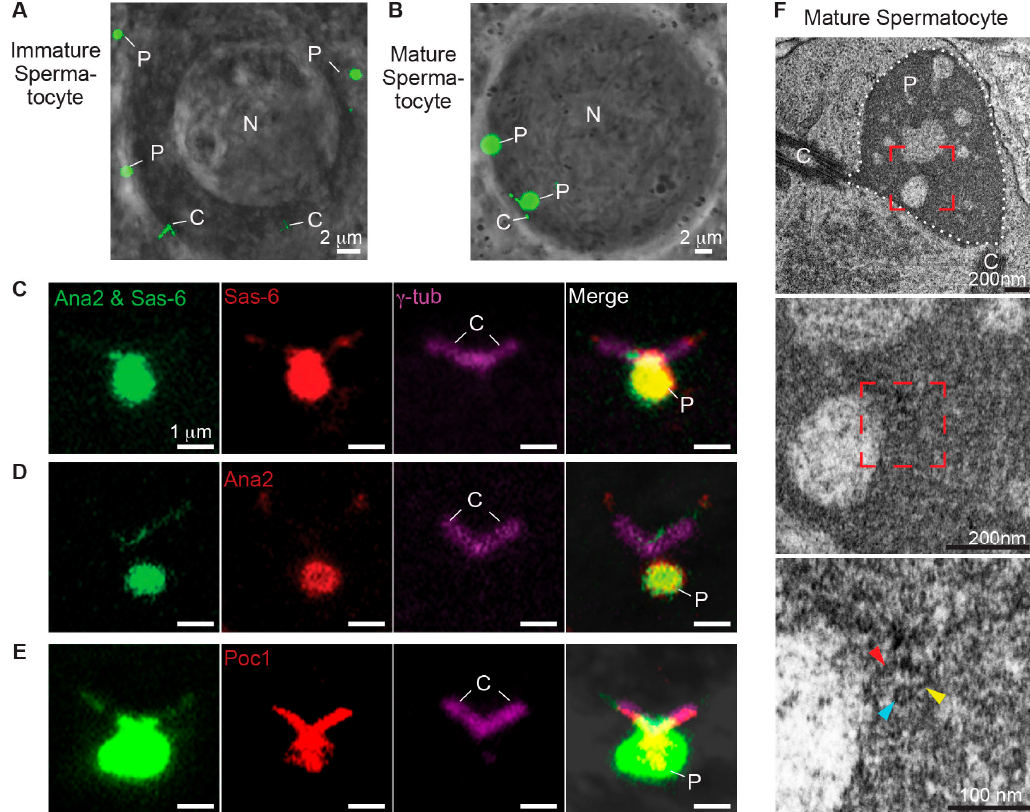
Figure 4. Ectopic particles contain Poc1B . ( A , B ) Co-overexpression of Ana2GFP and Sas-6GFP induced the formation of ectopic particles. Immature spermatocyte contained two centrioles (C) and ectopic particles (P) in the cytoplasm (A). Mature spermatocyte contained ectopic particles connected to the two centrioles and in the cytoplasm (B). Images were obtained by live cell imaging. ( C–E ) Ectopic particles were attached to the γ -tubulin labeled centrioles. Sas-6 antibodies labeled the particle and the centrioles’ tip ( C ), Ana2 antibodies labeled the particle and centrioles’ tip ( D ), and Poc1 antibodies labeled the particle and the centrioles ( E ). ( F ) Ectopic particles were composed of PCL-like structures in mature spermatocytes. Low electron microscopy magnification (upper row) showed dense PCL-like structures attached to the two centrioles (red dotted box). The electron dense area is outlined with white dotted lines. Intermediate magnification (middle row) showed PCL-like structures embedded in an electron-dense area. High magnification (lower row) showed that PCL-like structures consisting of tubule-like structures (blue arrowhead), spokes (yellow arrowhead), and electron-dense material (red arrowhead) in mature spermatocytes. C, Centrioles; P, Particles.